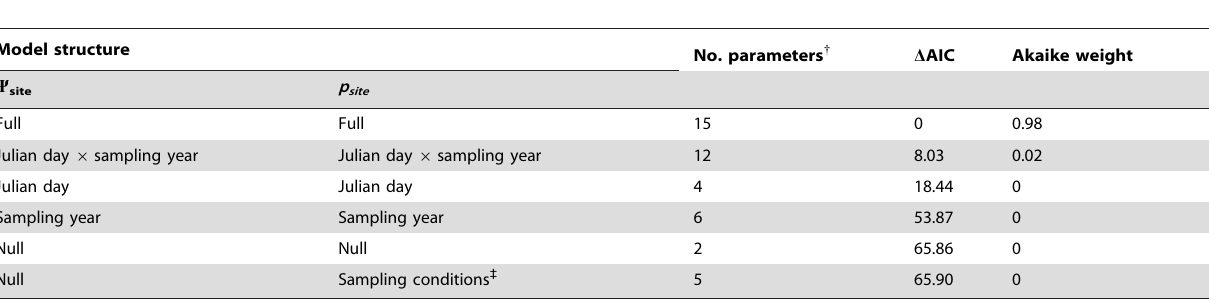
Table 3. Ranked two-state models of parental status ( Y site ; according to Julian day and sampling year) and its detection probability ( p site ; according to sampling conditions) at site level ( n = 393